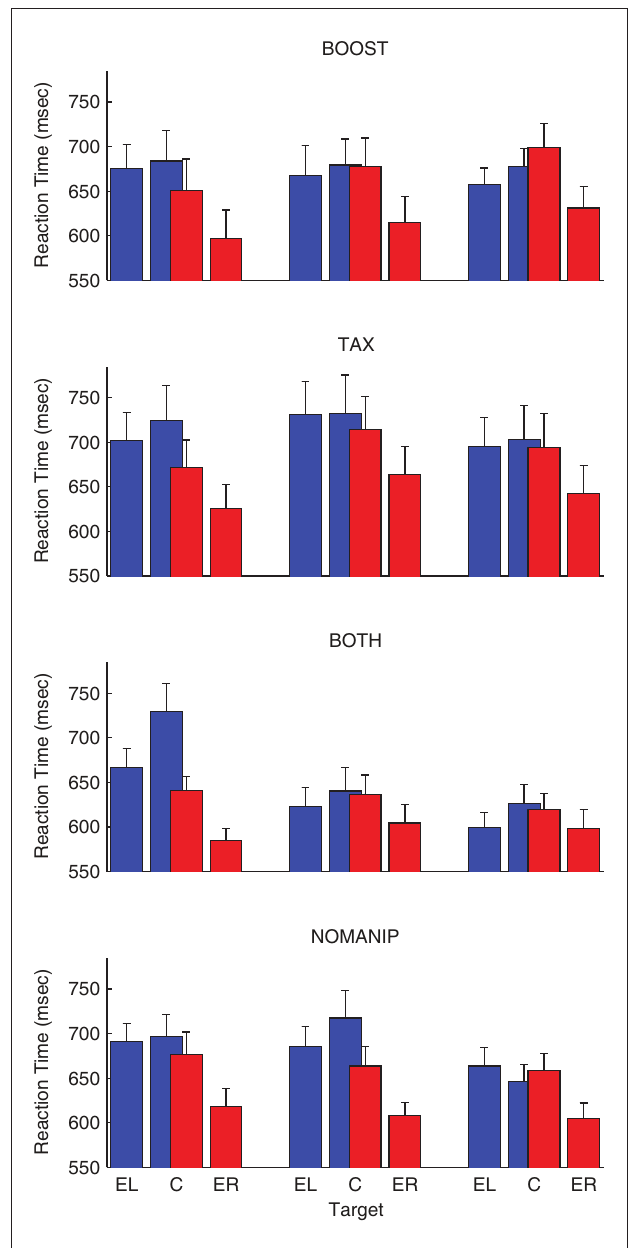
Figure 5 | Left (blue) and right (red) hand reaction time data for experiment 1. For each condition, the data are plotted separately for the three phases (baseline: left cluster; manipulation: center cluster; post-manipulation: right cluster). Within each cluster, the data were combined for eccentric targets at ± 30 ° and ± 17.4 ° for the left and right hands (EL and ER). Data for the central target (C) is depicted separately for right and left hand